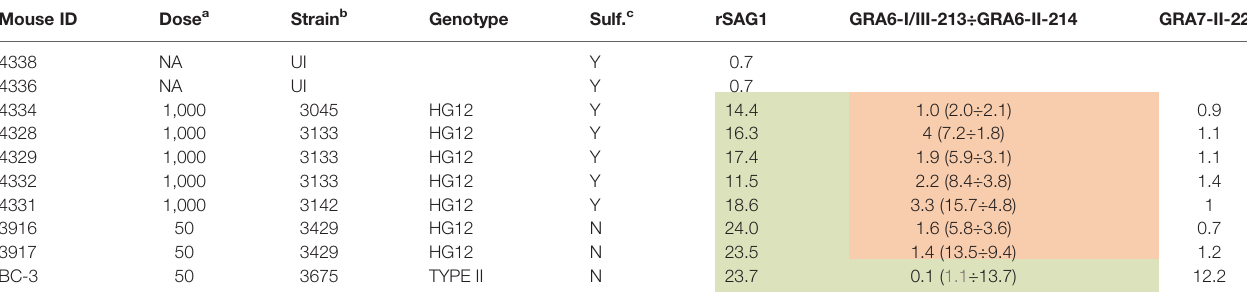
TABLE 2 | HG12 mouse serum samples react distinctively against GRA6